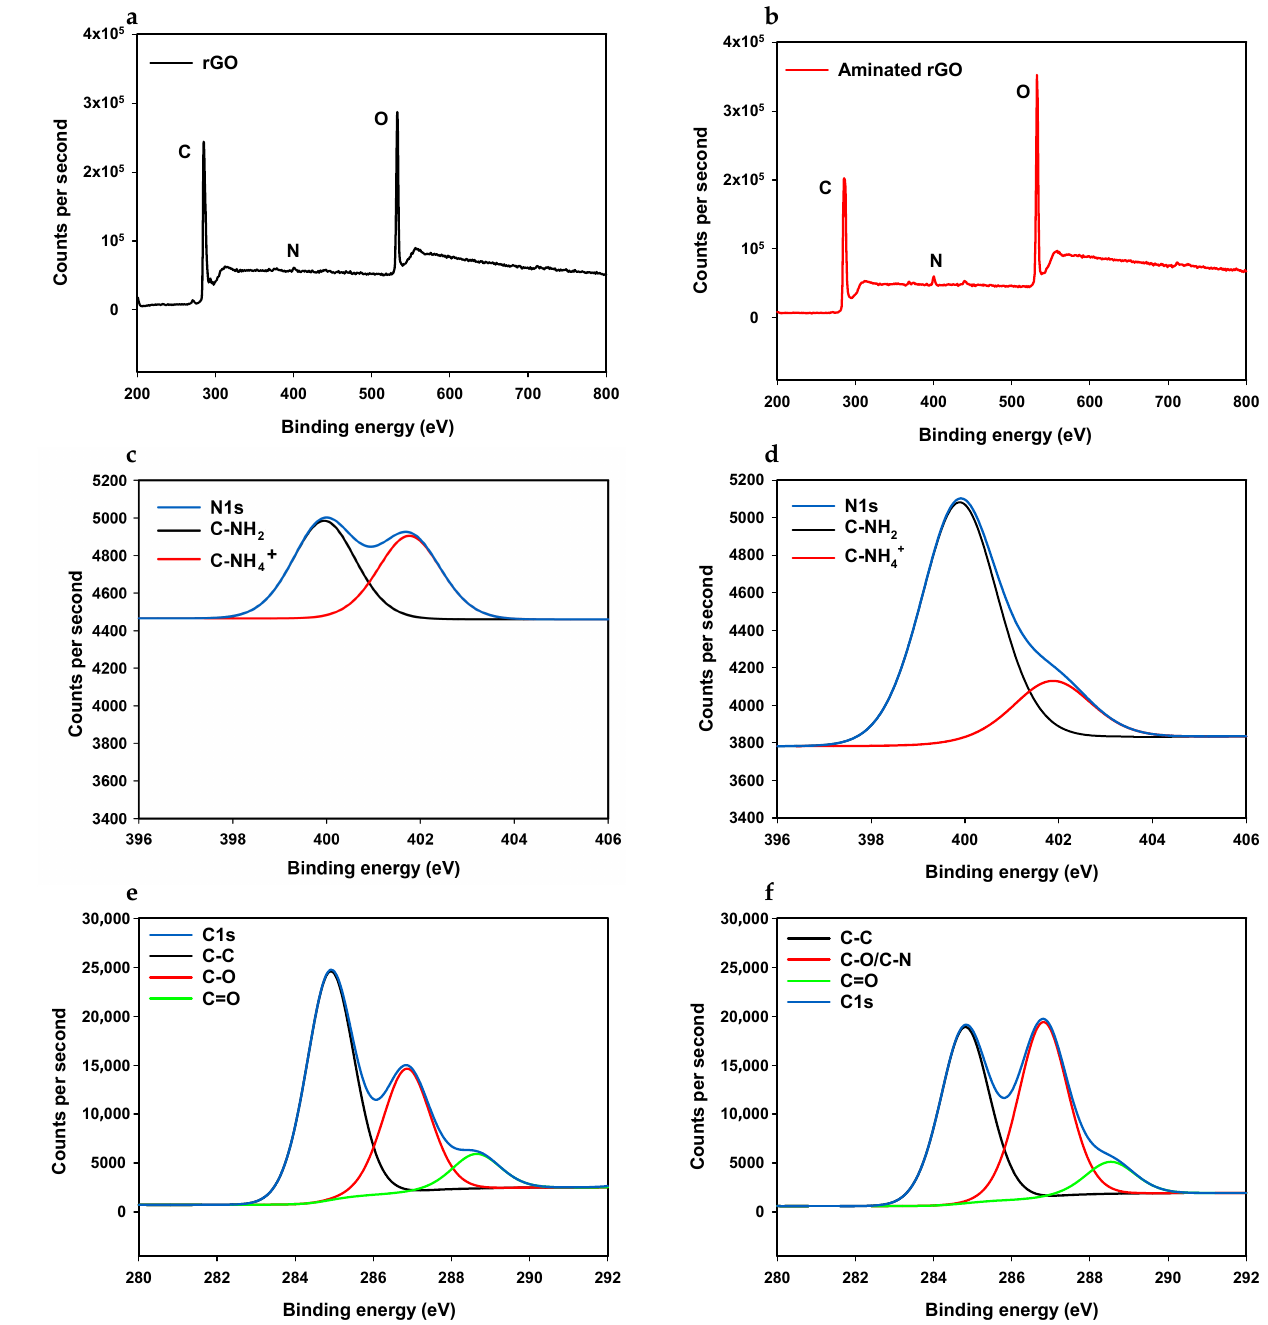
Figure 2. XPS spectra of rGO and aminated rGO electrodes. Survey scan of a bare rGO electrode ( a ) and an aminated electrode ( b ). N1s high resolution spectra of bare rGO ( c ) and aminated rGO ( d ) electrodes and C1s high resolution spectra of bare rGO ( e ) and aminated rGO ( f )